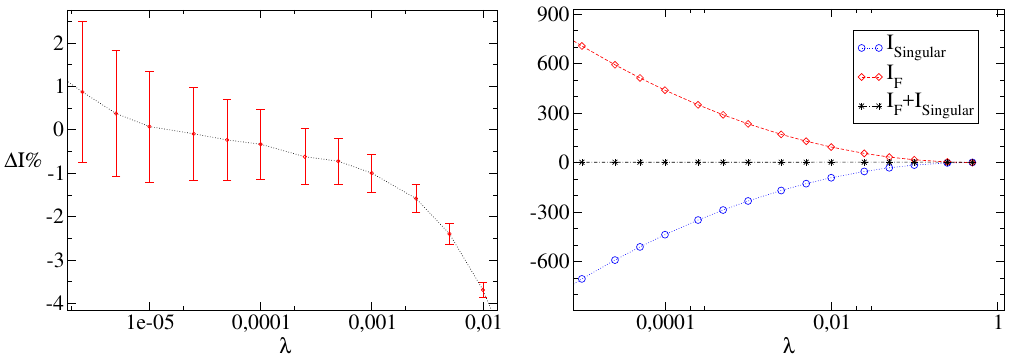
Figure 3 . This (cid:12)gure shows (cid:1) I ( (cid:21) ) on the left and also separately the (cid:15) 0 coe(cid:14)cients of I F ; I Singular and their sum on the right in the slicing method. In both (cid:12)gures I F is evaluated numerically with the CUBA implementation of the Vegas algorithm using 10 8 points for each value of (cid:21)